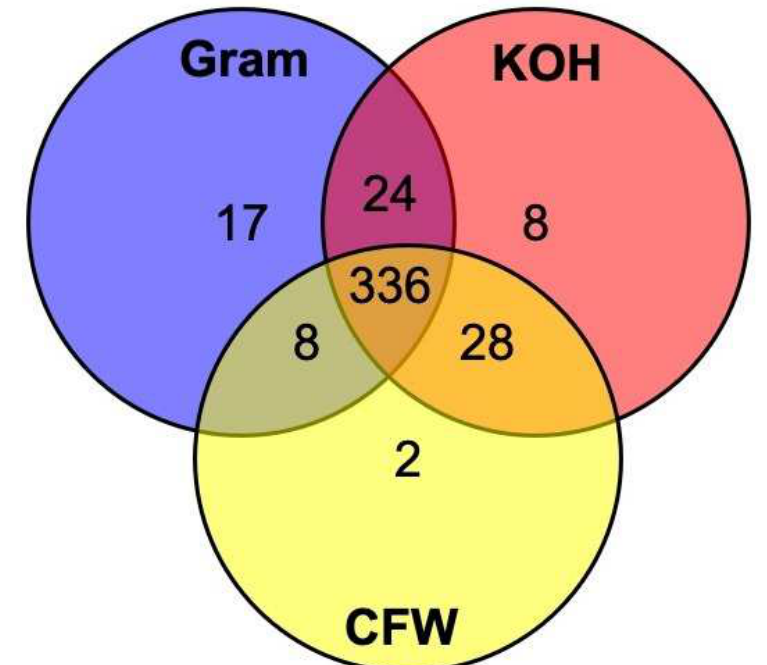
Figure 2. Venn diagram showing the number of cases that were positive for diagnosing filamentous fungal keratitis (including mixed bacterial-fungal cases) by smear microscopy ( n = 423) using different smear microscopy stains: Gram, potassium hydroxide (KOH), and calcofluor white (CFW). Cases that were positive for more than one stain are given within the overlapping areas. Note that cases that were negative for all investigations are not included, and not all patients had all tests performed. Please refer to Table 3 for this information.